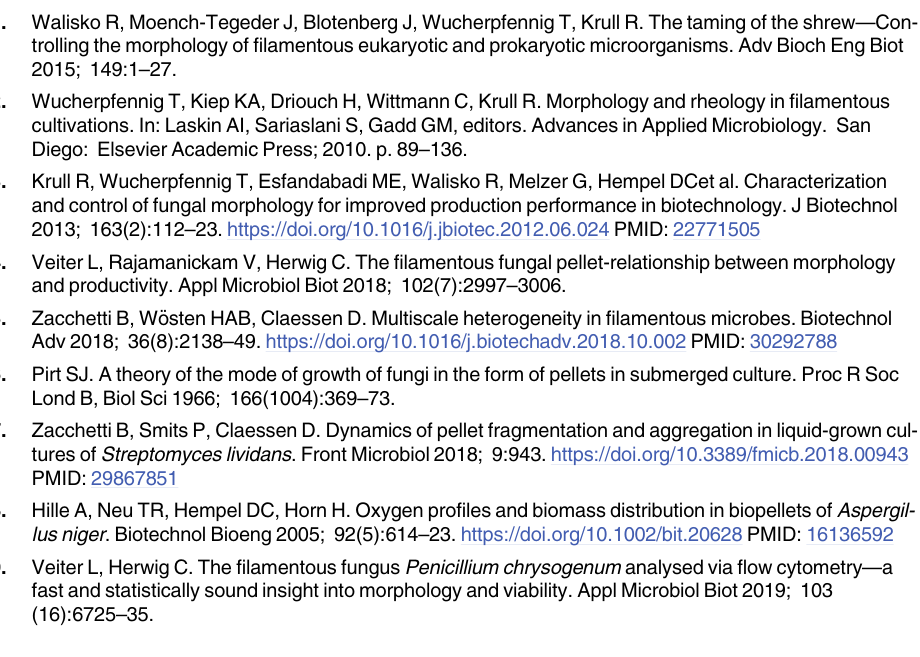
) and volume-density-distribution a ) of pellets a ) of pellets from cultures (c) with- a